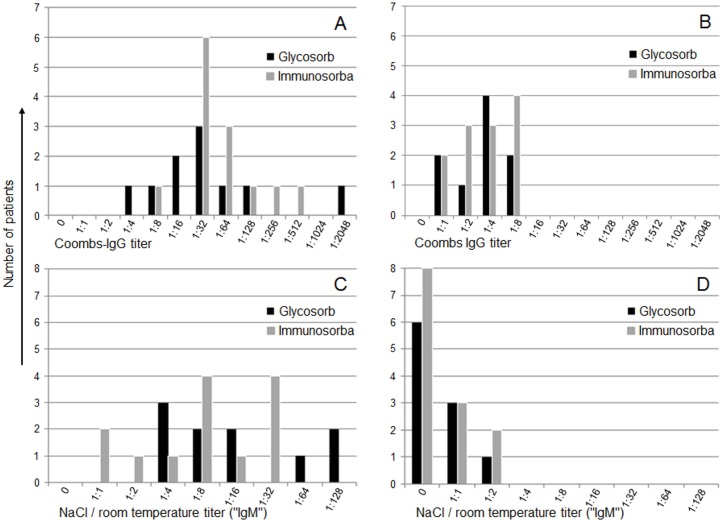
IgG- and IgM-titers (log steps) for each patient before first IA and before ABOi RTx.(A) IgG titers before first IA. (B) IgG titers before RTx. (C) IgM titers before first IA. (D) IgM titers before RTx.